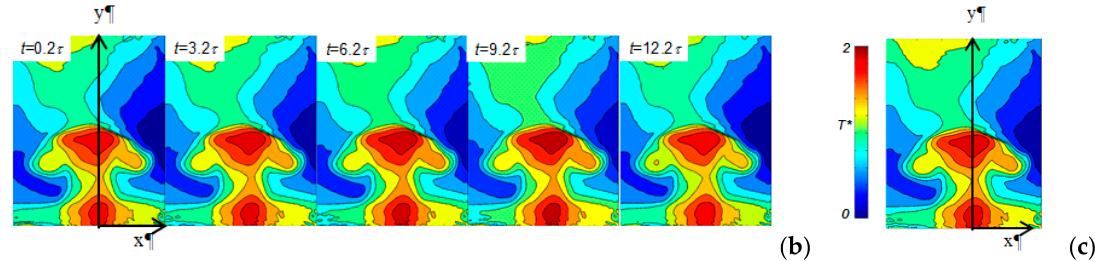
Figure 4. ( a ) Due to the synchronization of the camera trigger and the phenomenon, periodic development of SJ with period τ can be captured with a digital camera having a frame period of T CAM at any relative time within the SJ period [67], ( b ) 2D temperature fields of SJs measured at the same relative time at different periods (M) of the phenomenon. The similarity of the maps proves the coherence of the phenomenon ( c ); averaged SJ temperature fields from different periods of the phenomenon, see ( b ).